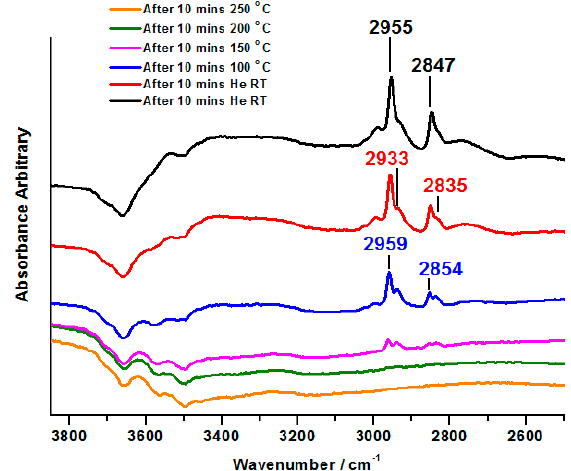
Figure 21. In situ DRIFTS spectra for 6ML MoO x /Fe 2 O 3 under TPD of MeOH/He. The catalyst surface was saturated with MeOH pulses under He at room temperature, and two spectra were then taken with one 10 min after the other (black and red curves). The temperature was then raised to 400 ˝ C, monitoring the reaction products through TPD with simultaneous DRIFTS analysis of the surface